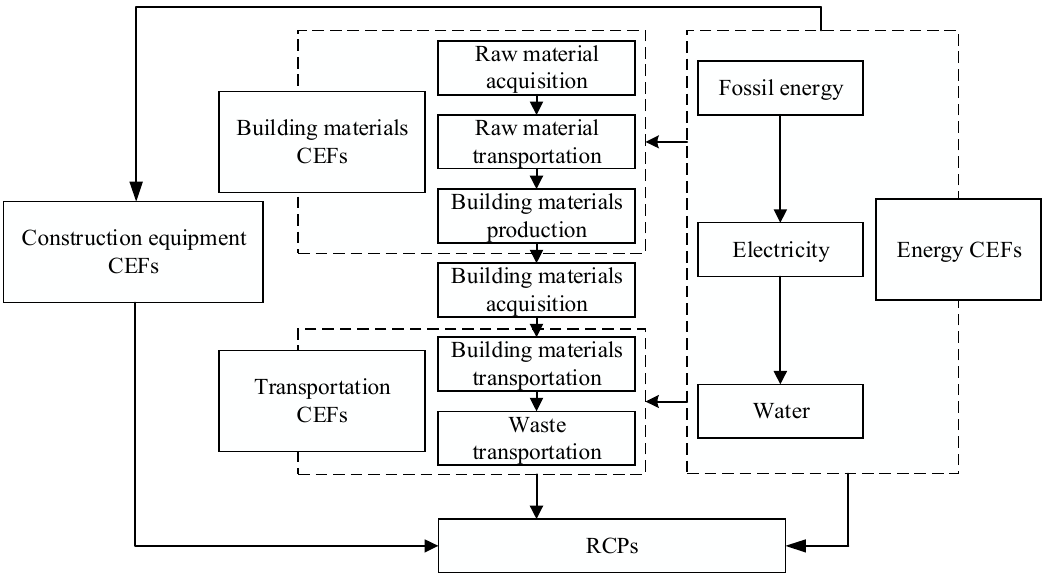
Figure 1. Relationship between energy, transportation, building materials, and construction equipment